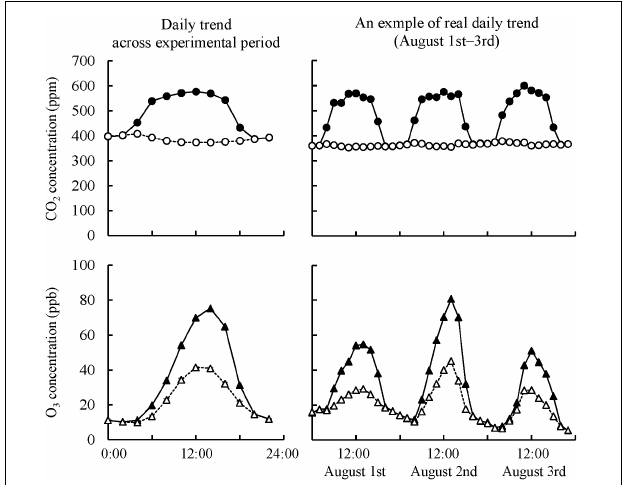
FIGURE 2 | Daily trend of CO 2 and O 3 concentrations in the chamber of the FACE system across experimental period and an example of real daily trend on August 1st–3rd, 2011. Open circle, ambient CO 2 as mean value of [Control] and [O 3 ] treatments; solid circle, elevated CO 2 as mean value of [CO 2 ] and [CO 2 + O 3 ] treatments; open triangle, ambient O 3 as mean value of [Control] and [CO 2 ] treatments; solid triangle, elevated O 3 as mean value of [O 3 ] and [CO 2 + O 3 ]